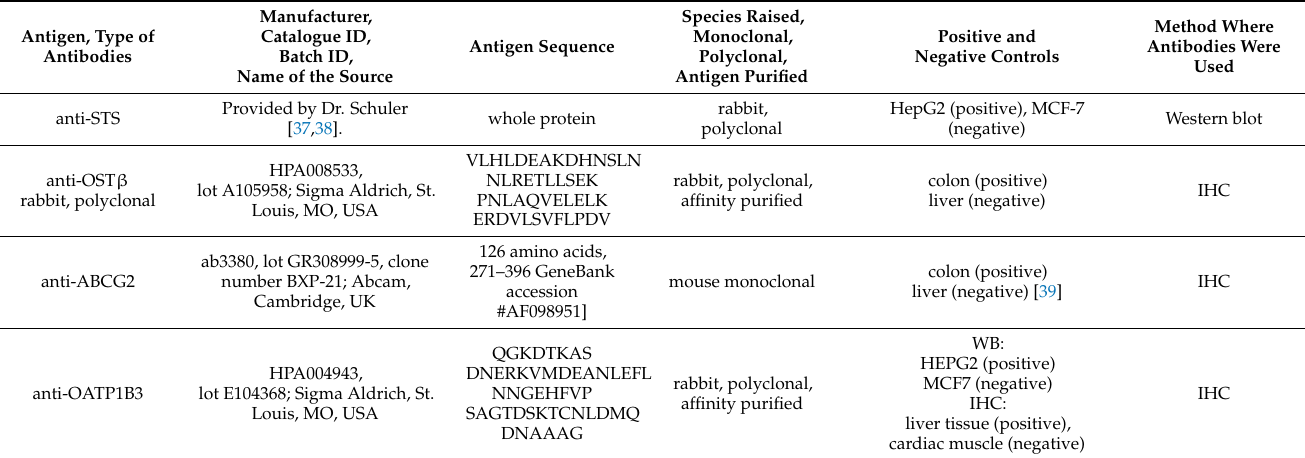
Table 2. Data on the antibodies used for Western blotting or immunohistochemistry